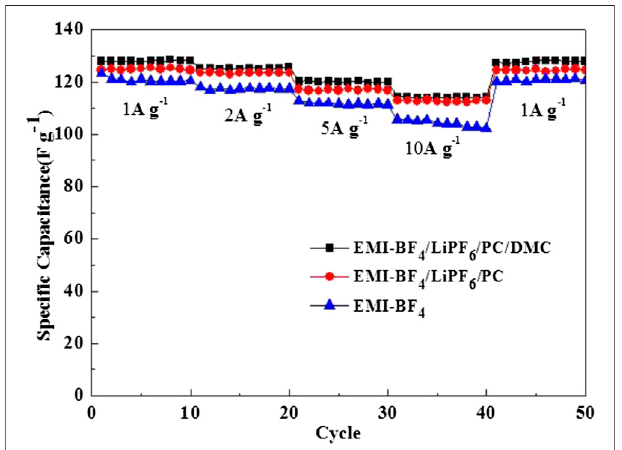
FIGURE 5 | Rate performances of the EDLCs in various electrolytes at current densities ranging from 1 A g − 1 – 10 A g − 1 .